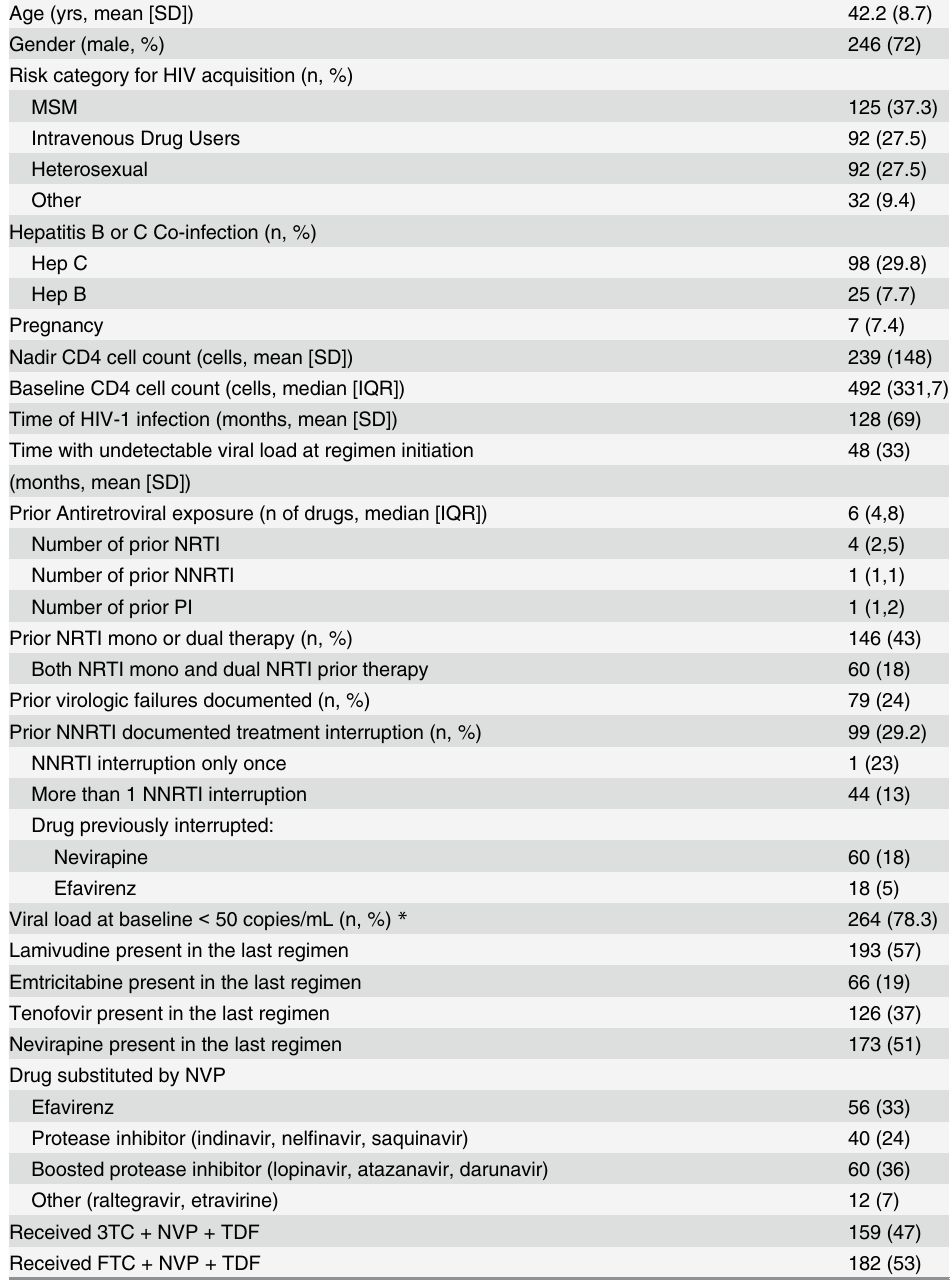
Table 1. Patient characteristics at the initiation of NVP plus TDF plus FTC (or 3TC) as a switch strategy (n =